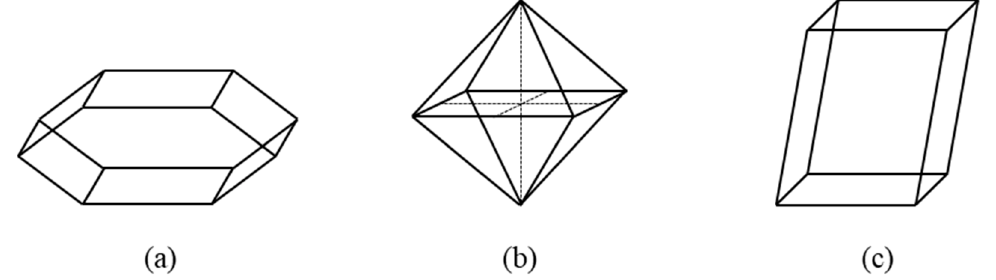
Figure 8. The morphologies of the different hydrates for CaOx crystals: ( a ) monoclinic prismatic monohydrate (COM); ( b ) tetragonal dipyramidal dihydrate (COD); ( c ) triclinic trihydrate (COT) [36].